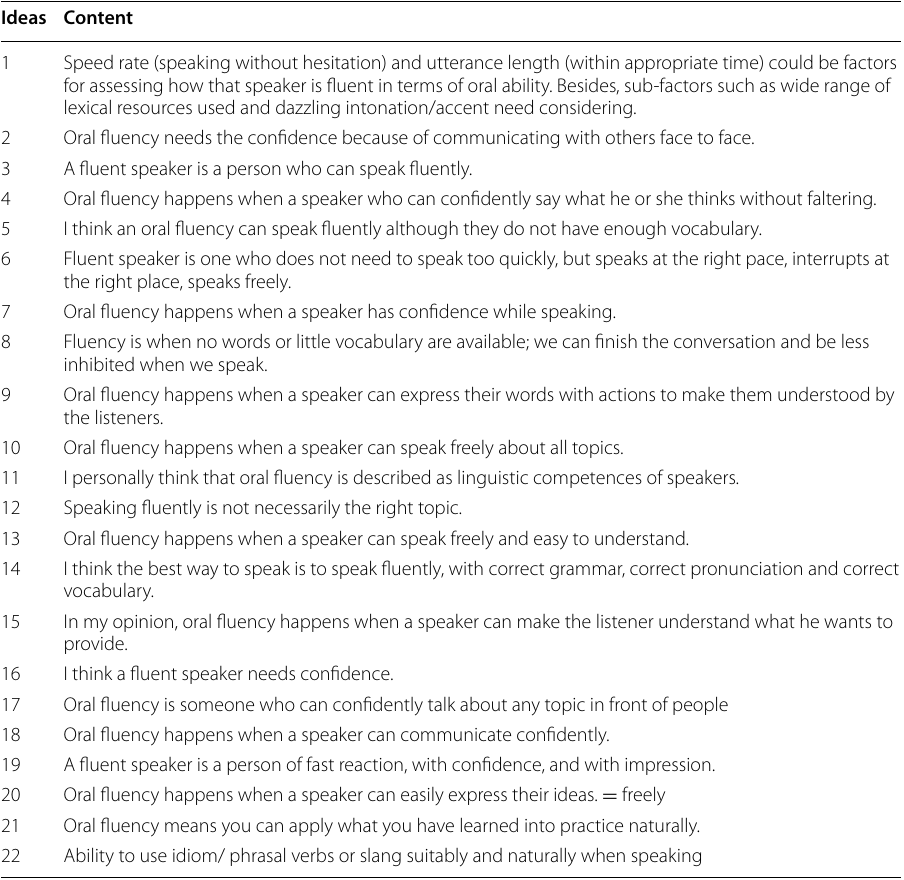
Table 6 The participants’ own ideas on oral fluency Ideas